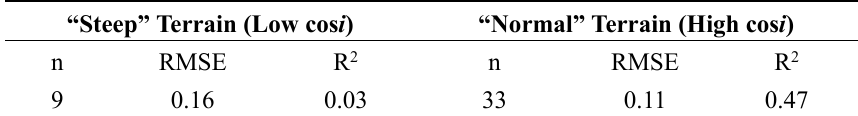
Figure 11. Validation of estimated fAPAR against in situ measured fAPAR (33 plots with high cos i ). Table 6. Accuracy of forest fAPAR from INFORM against field measured values. We distinguish steep terrain (e.g., low cosi ) and normal terrain (e.g., high cosi ). “Steep” Terrain (Low cos i